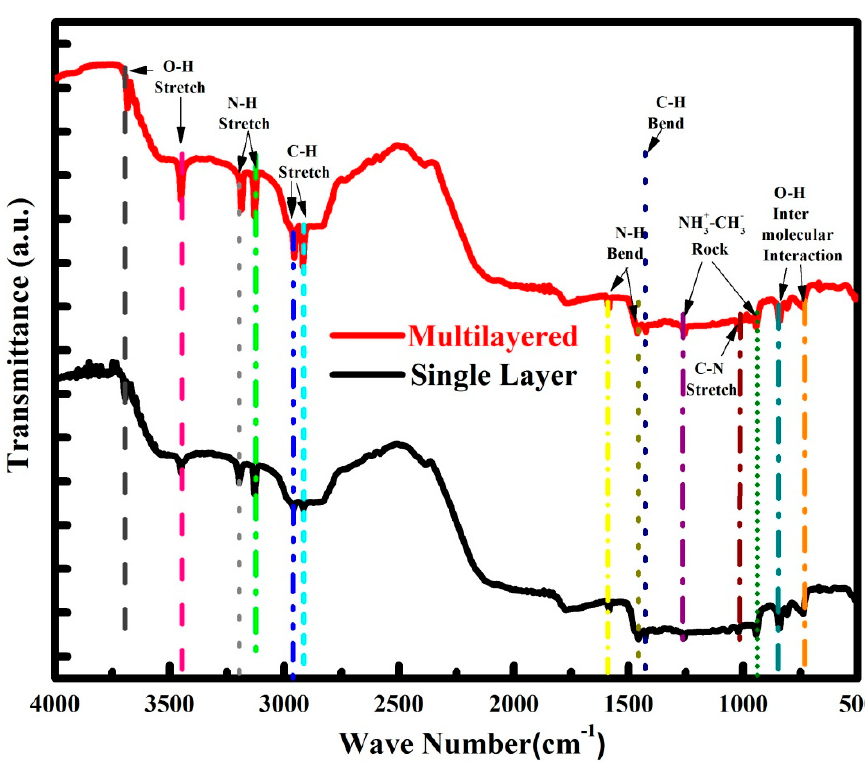
Figure 7. FTIR spectra for single-layer and multilayer CH 3 NH 3 PbIBr 2 thinfilms.